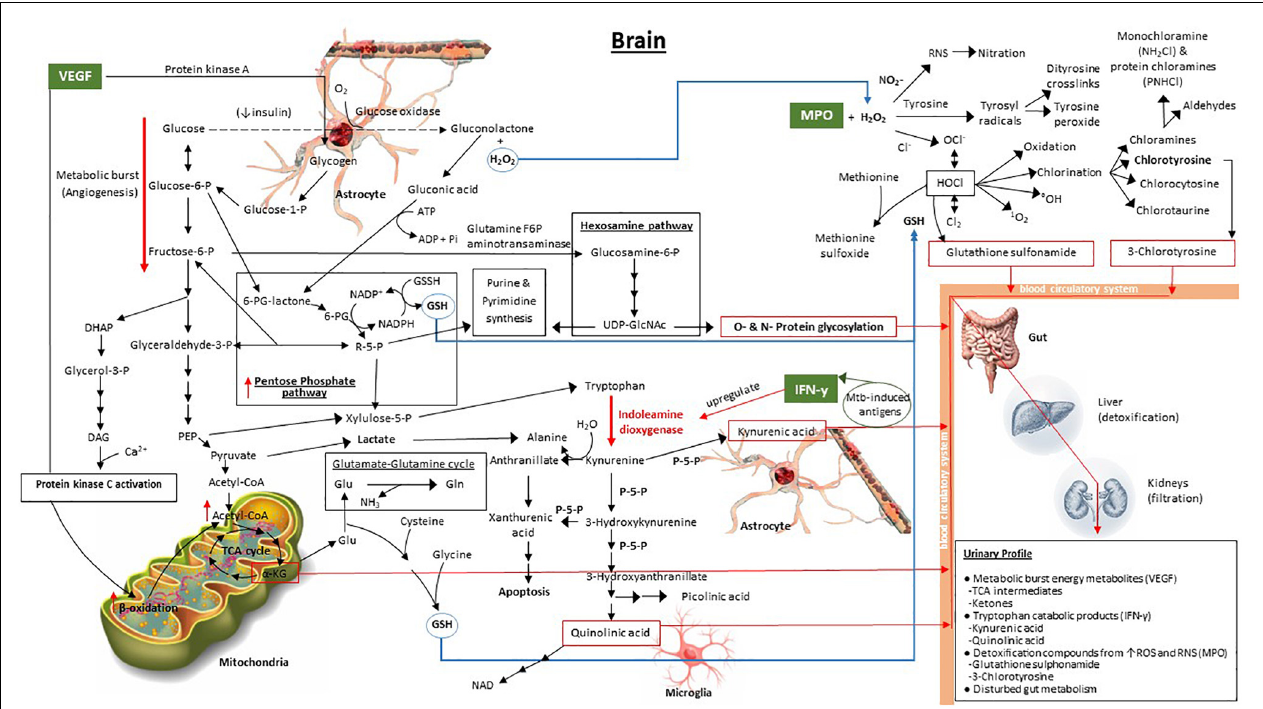
FIGURE 1 | Model predicting the downstream metabolic effects of VEGF, IFN- γ , and MPO in the brain, and the expected attendant urinary profile, in a TBM patient. The bold red arrows indicate the major upregulated metabolic pathways, namely tryptophan catabolism, induced by upregulated indoleamine dioxygenase due to IFN- γ , and increased metabolic burst (angiogenesis) via increased glycolysis. The red boxes enclose metabolic end-products within the Mtb-infected brain – protein glycosylation, α -ketoglutarate, quinolinic acid, kynurenic acid, 3-chlorotyrosine and glutathione sulfonamide – which are the predicted metabolic brain markers of TBM. The blue arrows indicate the transport of important metabolic components. The dashed black line, indicating oxidation of glucose to gluconolactone, represents a transient pathway that occurs when insulin is depleted, as indicated. 6-PG, 6-phosphogluconate; R5P, ribulose-5-phosphate; UDP-GlcNAc, UDP-N-acetylglucosamine; PEP, phosphoenolpyruvate; DHAP, dihydroxyacetone phosphate; DAG, diacylglycerol; TCA cycle, tricarboxylic acid (citric acid) cycle; α -KG, α -ketoglutarate; Glu, glutamate; Gln, glutamine; GSH, glutathione (reduced); P-5-P, pyroxidal-5-phosphate (vitamin B 6